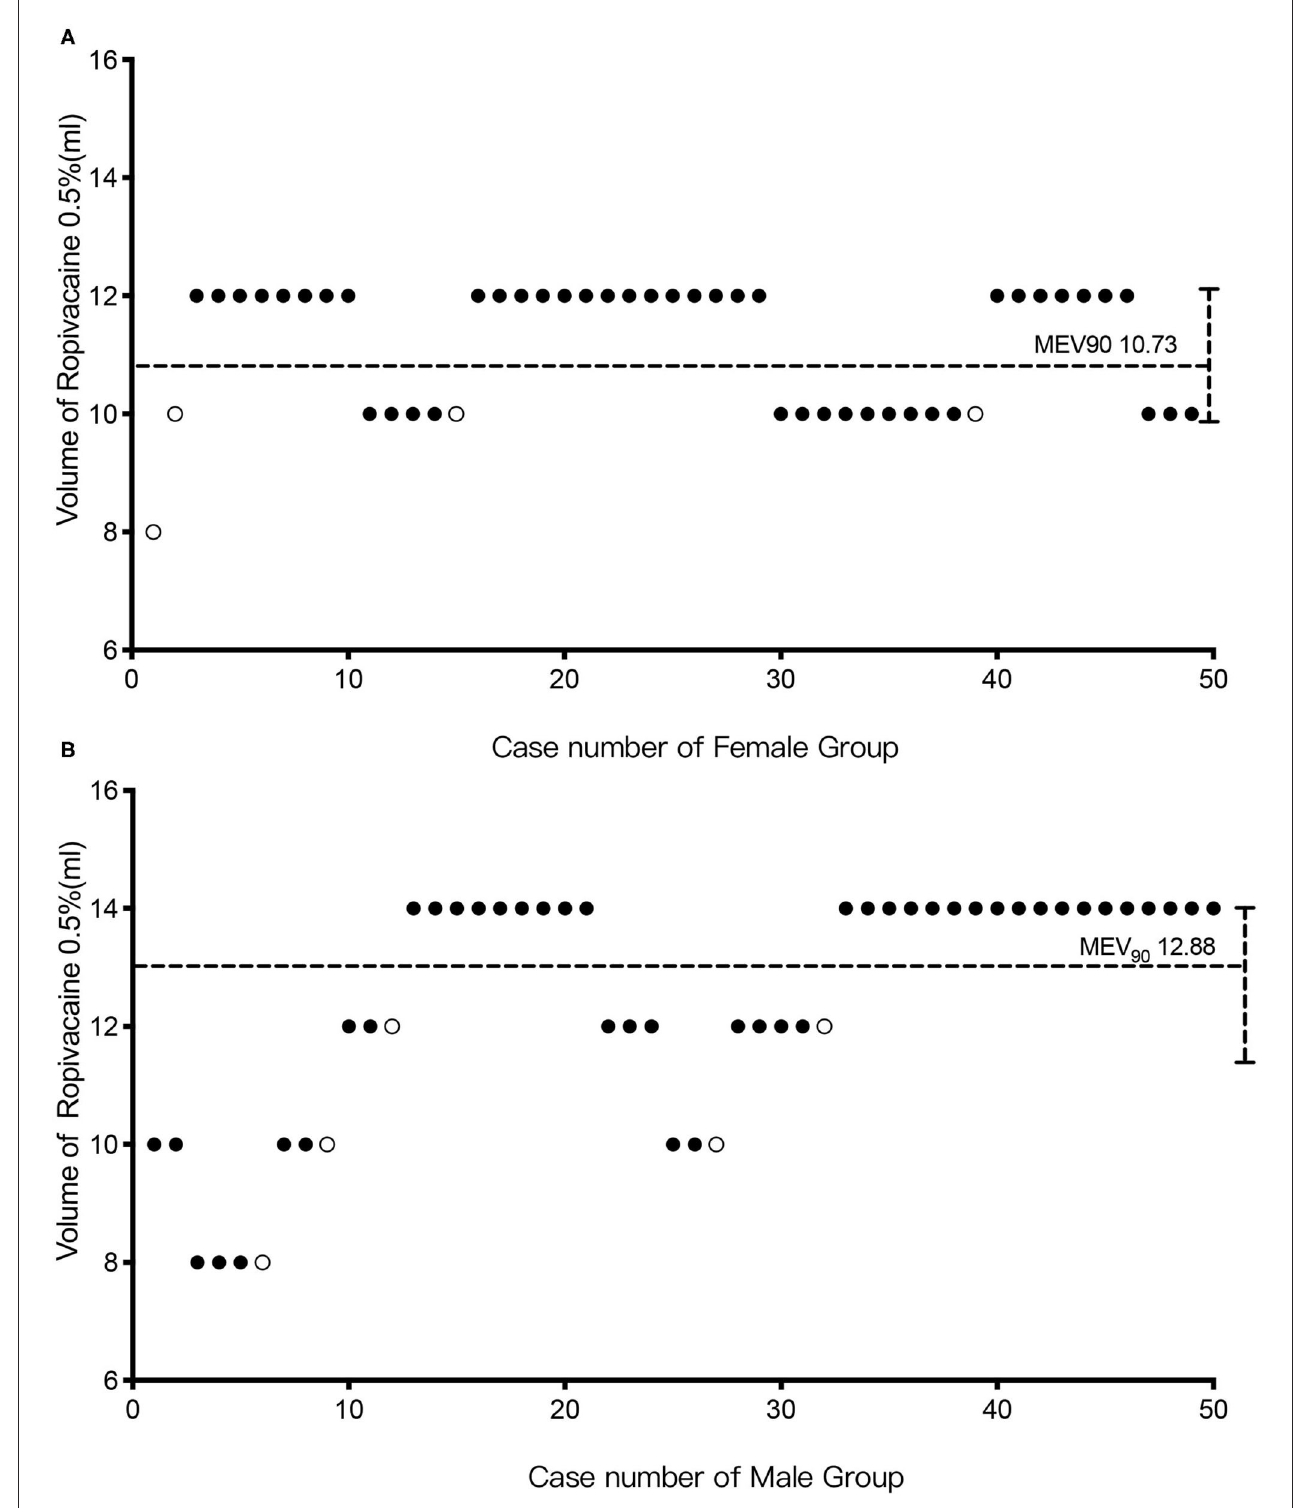
FIGURE3 The biased coin design up-and-down sequence. Graph of successful (solid circle) and failed (hollow circle) caudal epidural blocks with different ropivacaine volumes in the female (A) and male groups (B) . The horizontal line is the calculated minimum effective volume of 0.5% ropivacaine providing successful caudal block in 90% of patients